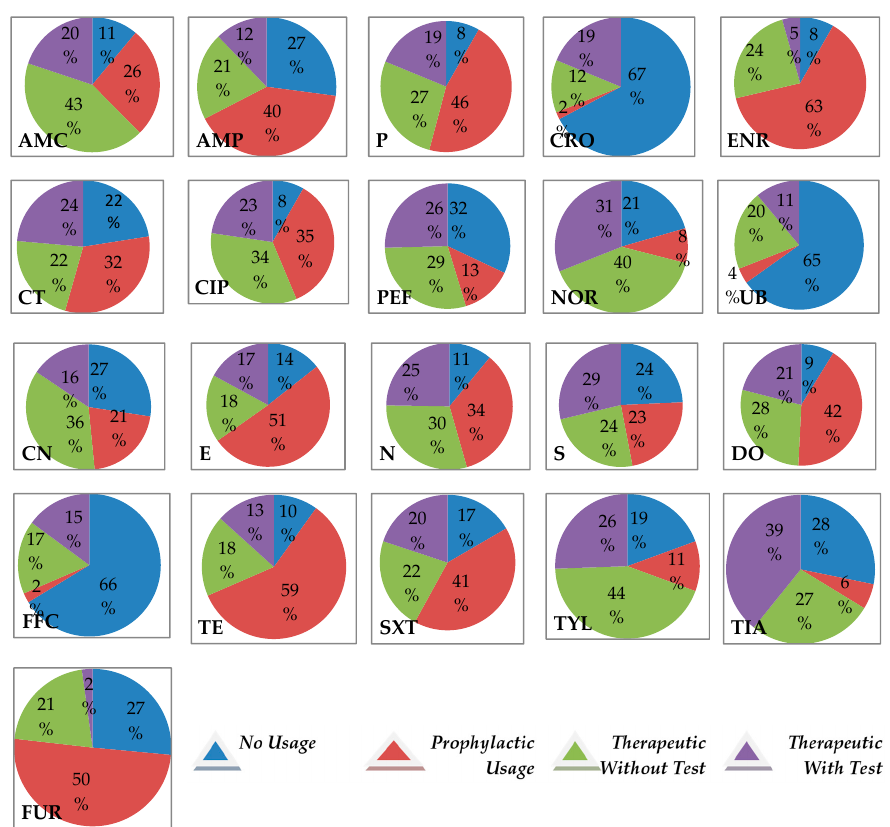
Figure 2. Profiling of purposes of antimicrobial drug administration in the Nigeria broiler production chain Note: AMC = Amoxicillin clavulanic, AMP = Ampicillin, CIP = Ciprofloxacin, CN = Gentamycin, CRO = Ceftriaxone, CT = Colistin, DO = Doxycycline, E = Erythromycin, ENR = Enrofloxacin, FFC = Florfenicol, FUR = Furazolidone, N = Neomycin 30, NOR = Norfloxacin, P = Penicillin G, PEF = Perfloxacin, S = Streptomycin, SXT = Co-trimoxazole (Trimethoprim-Sulphamethoxazole), TE = Tetracycline, TIA = Tiamulin, TYL = Tylosine, UB = Flumequine.